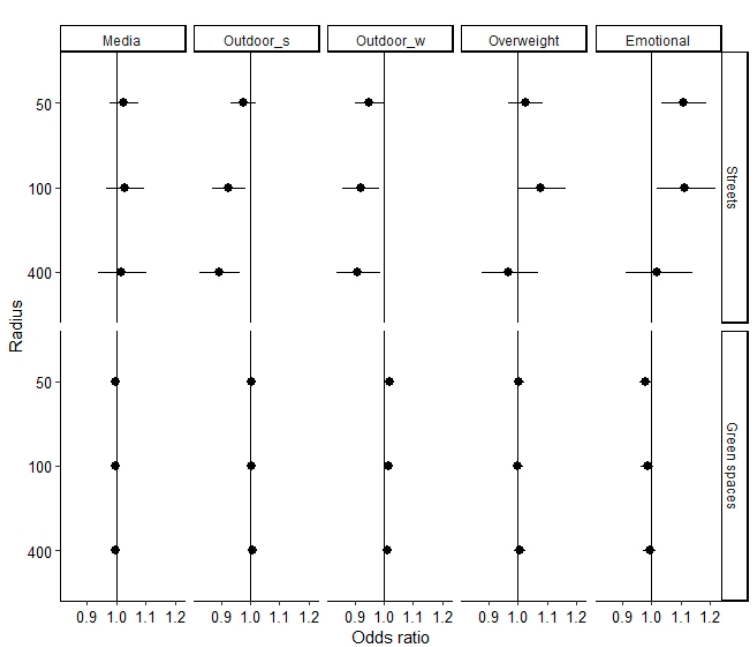
Figure 2. Associations ( + 95% CI) between parameters of the urban living environment and high media use (Media), frequent outdoor activity in summer (Outdoor_s) and winter (Outdoor_w), overweight/obesity (Overweight), and emotional problems (Emotional) in the sample of 10–19-year-old children. All associations are adjusted for child sex, age, family SES (composite score) and local SBR rate.